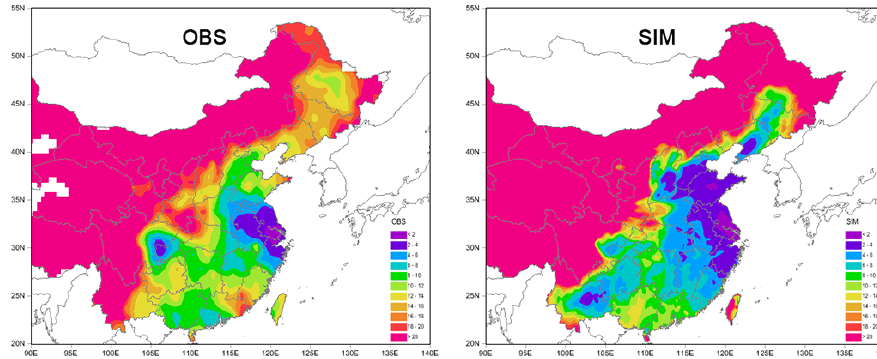
Figure 3. Mean (a) observed and (b) simulated visibility for 6–7 December 2013.